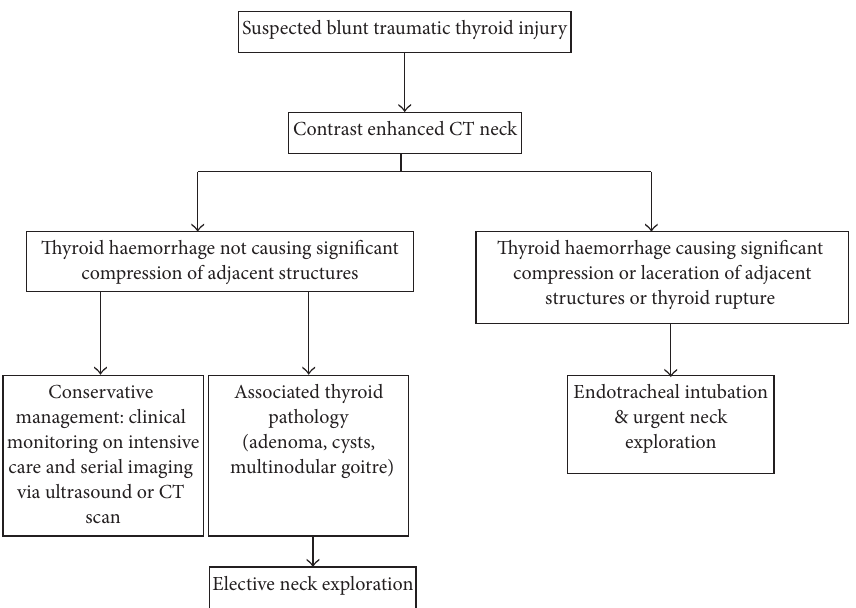
Figure 5: Adapted algorithm for the assessment and management of suspected thyroid haematoma from Heizmann et al. [1].